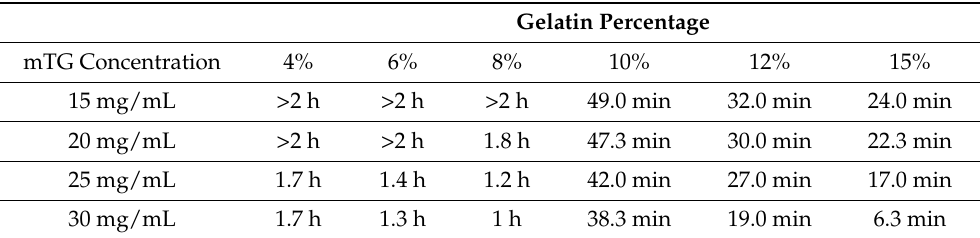
Table 1. Hydrogel gelation time of different concentrations of mTG with different concentrations of gelatin at room temperature (22 ◦